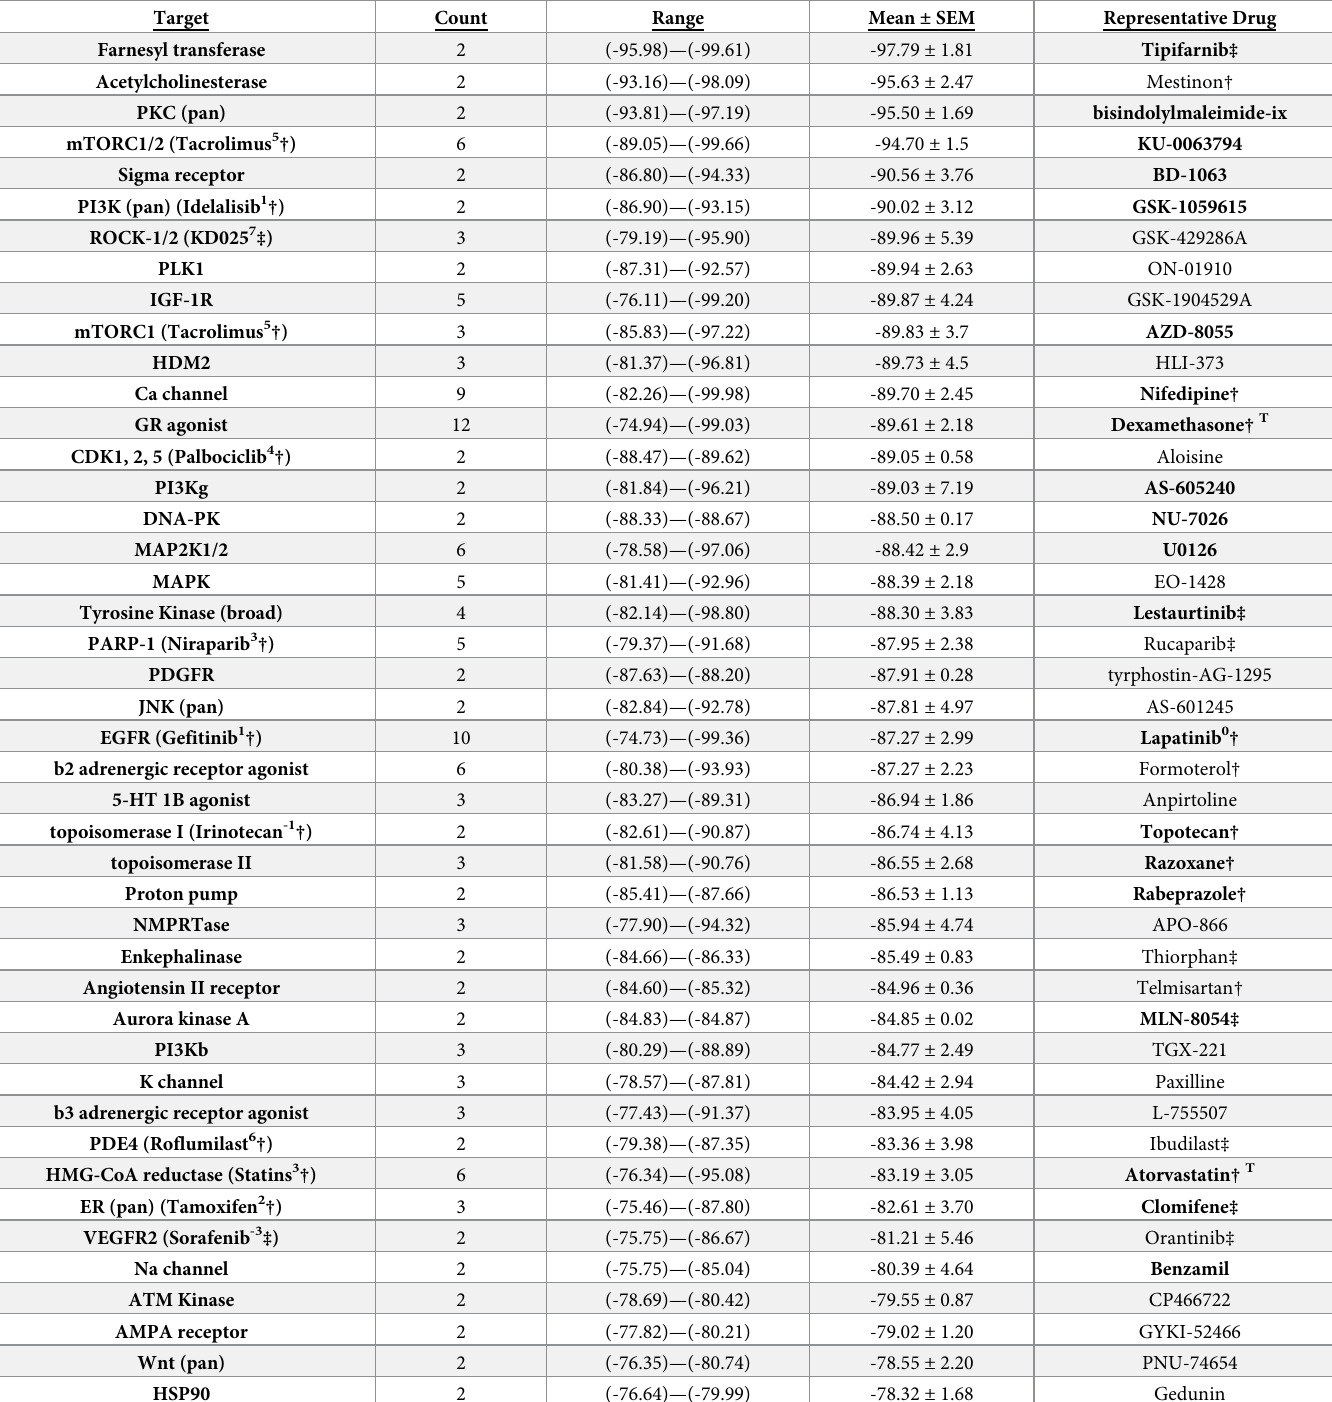
Table 1. Compounds targeting CD14 + monocyte pathways in active